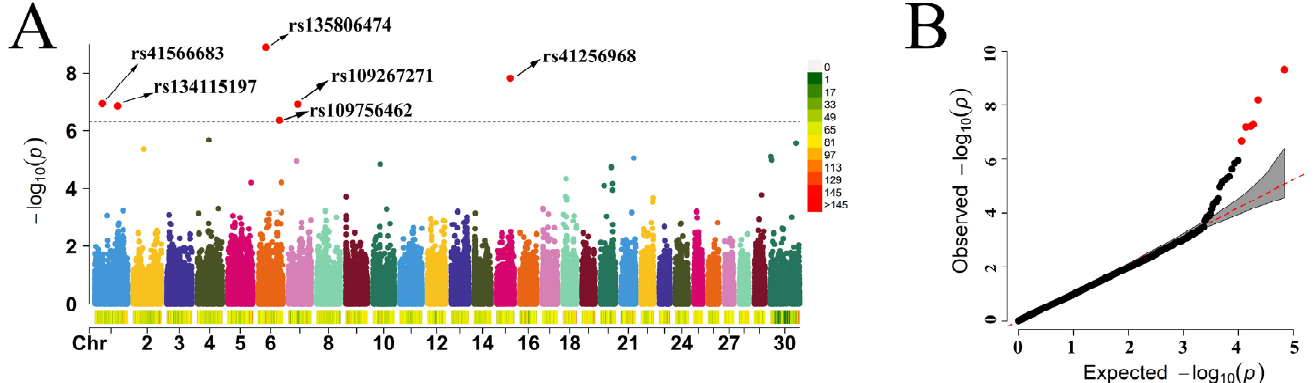
Figure 5. Manhattan plots ( A ) and quantile–quantile (QQ) plots ( B ) generated from association analysis result. Significant mutations are represented by red dots. Chromosomes and negative logarithms of the p -values for the variations are represented by abscissas and ordinates in the Manhattan plots, respectively ( A ). Negative logarithms of the anticipated p -values and the identified p -values of variations are represented by the abscissa and ordinate of the QQ plot, respectively ( B ). Table 3. Details on the detected significant SNPs and their closest genes.